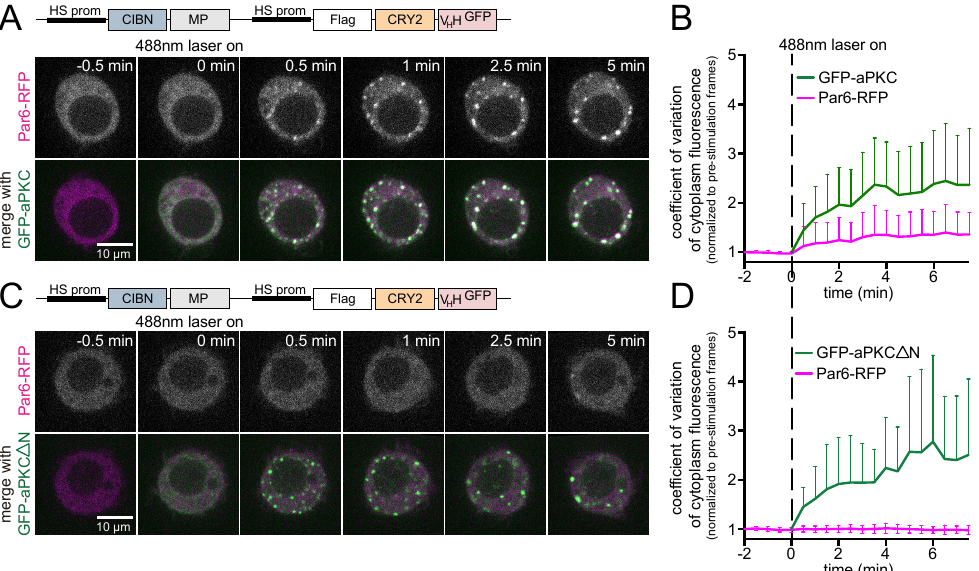
Figure 7. LARIAT detects aPKC and Par6 interaction in single cells. Representative timepoints of Drosophila S2 cells expressing Par6-RFP, CIBN-MP, Flag-CRY2-V H H, and ( A ) GFP-aPKC or ( C ) GFP-aPKC ∆ N analyzed through live-imaging. ( B , D ) Par6-RFP and ( B ) GFP-aPKC or ( D ) GFP-aPKC ∆ N clustering is represented by the coefficient of variation of cytoplasm fluorescence. Graphs display mean ± SD. n ≥ 15 cells for each condition.